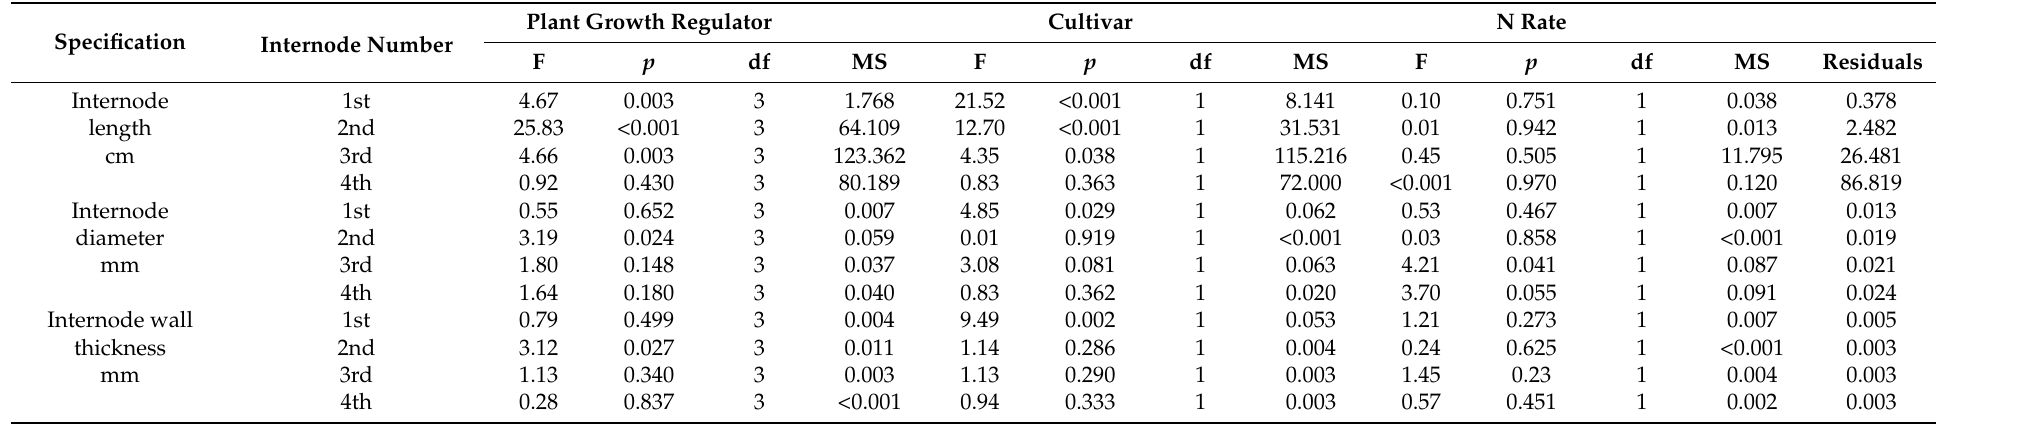
Table 2. Analysis of variance ( p and F values) for internode characteristics of red fescue generative tillers ( Festuca rubra ssp. rubra cv. Nista and F . r . ssp. commutata cv. Dorosa), for two production years and two field experiments.